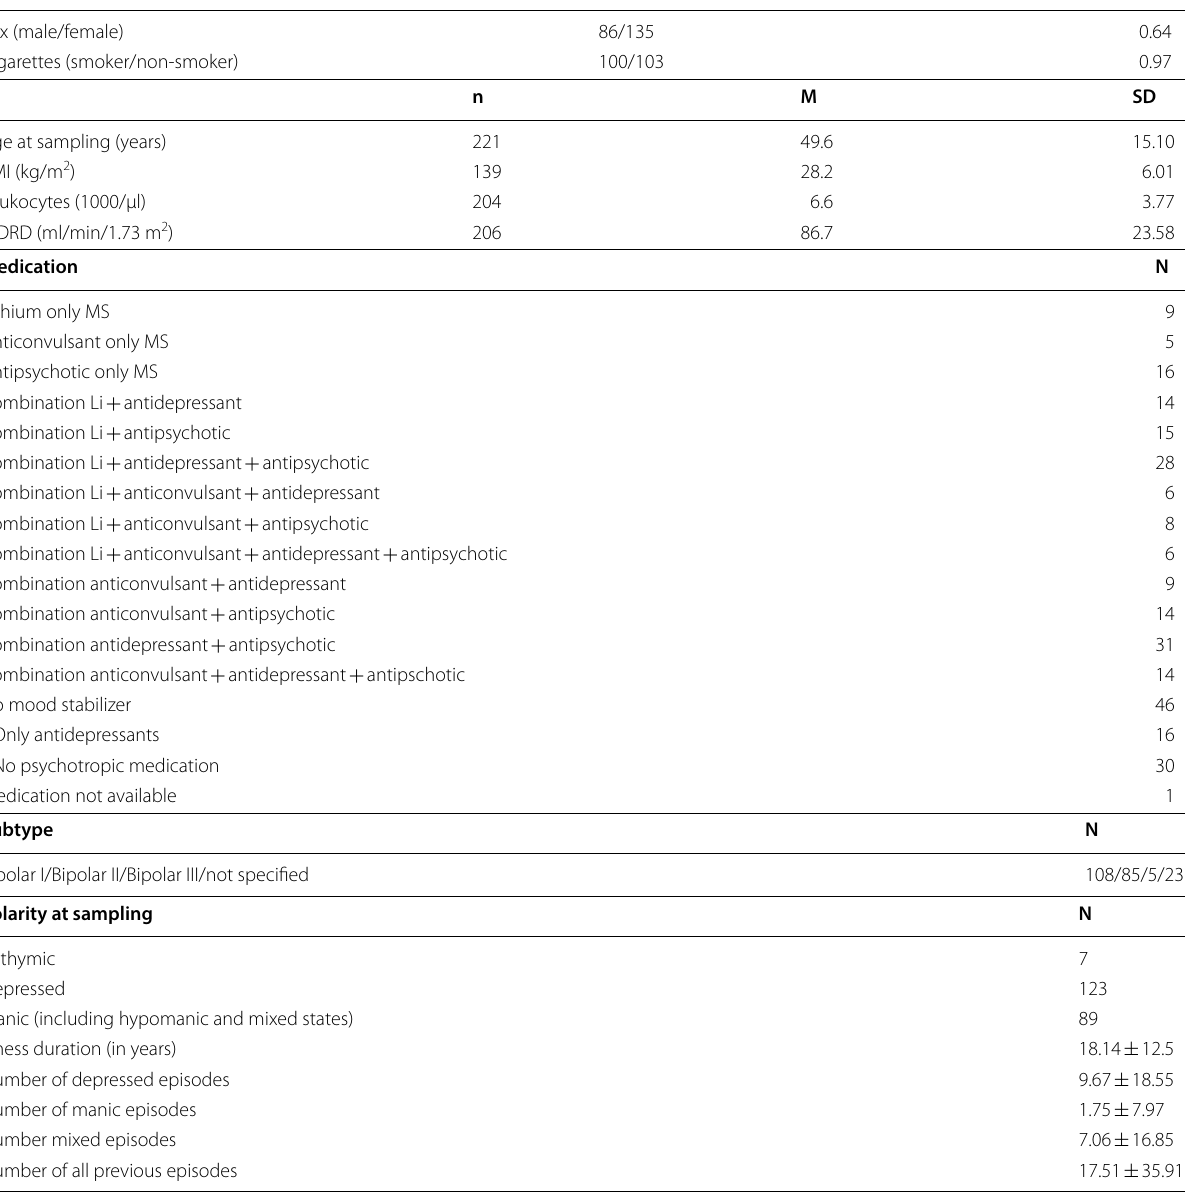
BMI body mass index, MDRD Modification of Diet in Renal Disease, MS mood stabilizer, Li